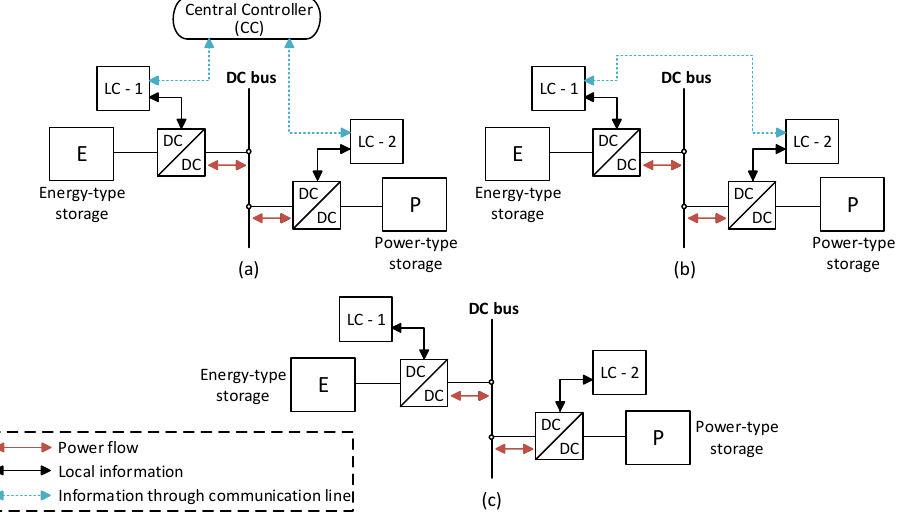
Figure 1. The schematic diagram of HESSs control methods: ( a ) Centralized; ( b ) distributed; ( c ) de- centralized.